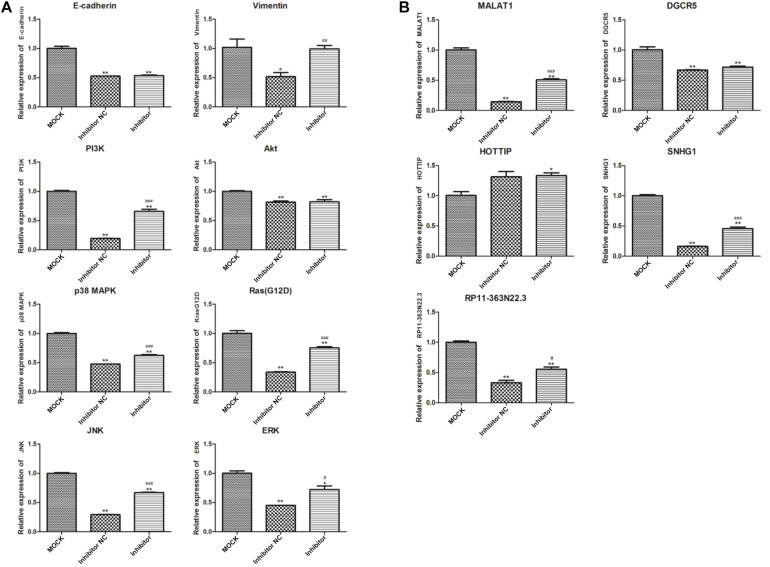
Expression detection of eight genes (A) and five lncRNAs (B) by quantitative polymerase chain reaction (qPCR). *p < 0.05 and **p < 0.01 compared to the MOCK group; #p < 0.05, ##p < 0.01, and ###p < 0.001 compared to the NC group. GAPDH was selected as the internal control. MOCK: CFPAC-1 only (without MSC exosome); Inhibitor NC: CFPAC-1 + MSC-hsa-miR-143-3p inhibitor negative control; Inhibitor: CFPAC-1 + MSC-miR-143 inhibitor group.